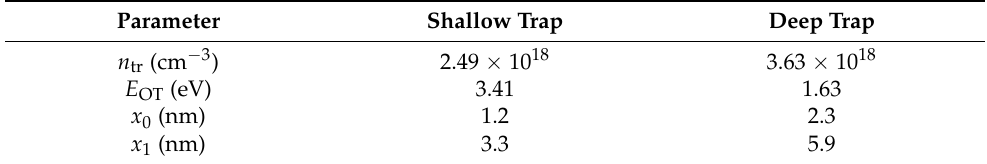
Figure 8. Dependencies of ∆ V TH ( t ) on ( a ) T and ( b ) V GS for the electrons trapped in the shallow trap under PBTS ( V GS = 40 V, V DS = 0 V, 80 ◦ C). Dependencies of ∆ V TH ( t ) on ( c ) T and ( d ) V GS for the electrons trapped in the deep trap under PBTS ( V GS = 40 V, V DS = 0 V, 80 ◦ C). Table 1. Extracted values of n tr , x 0 , x 1 , and E OT for electrons trapped in shallow and deep traps under PBTS ( V GS = 40 V, V DS = 0 V, 80 ◦ C) in the fabricated IGZO